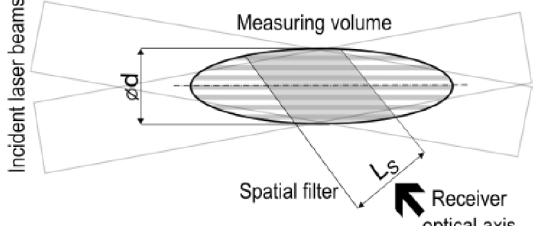
Fig. 1 . Schematic layout of the fibre based PDA system.